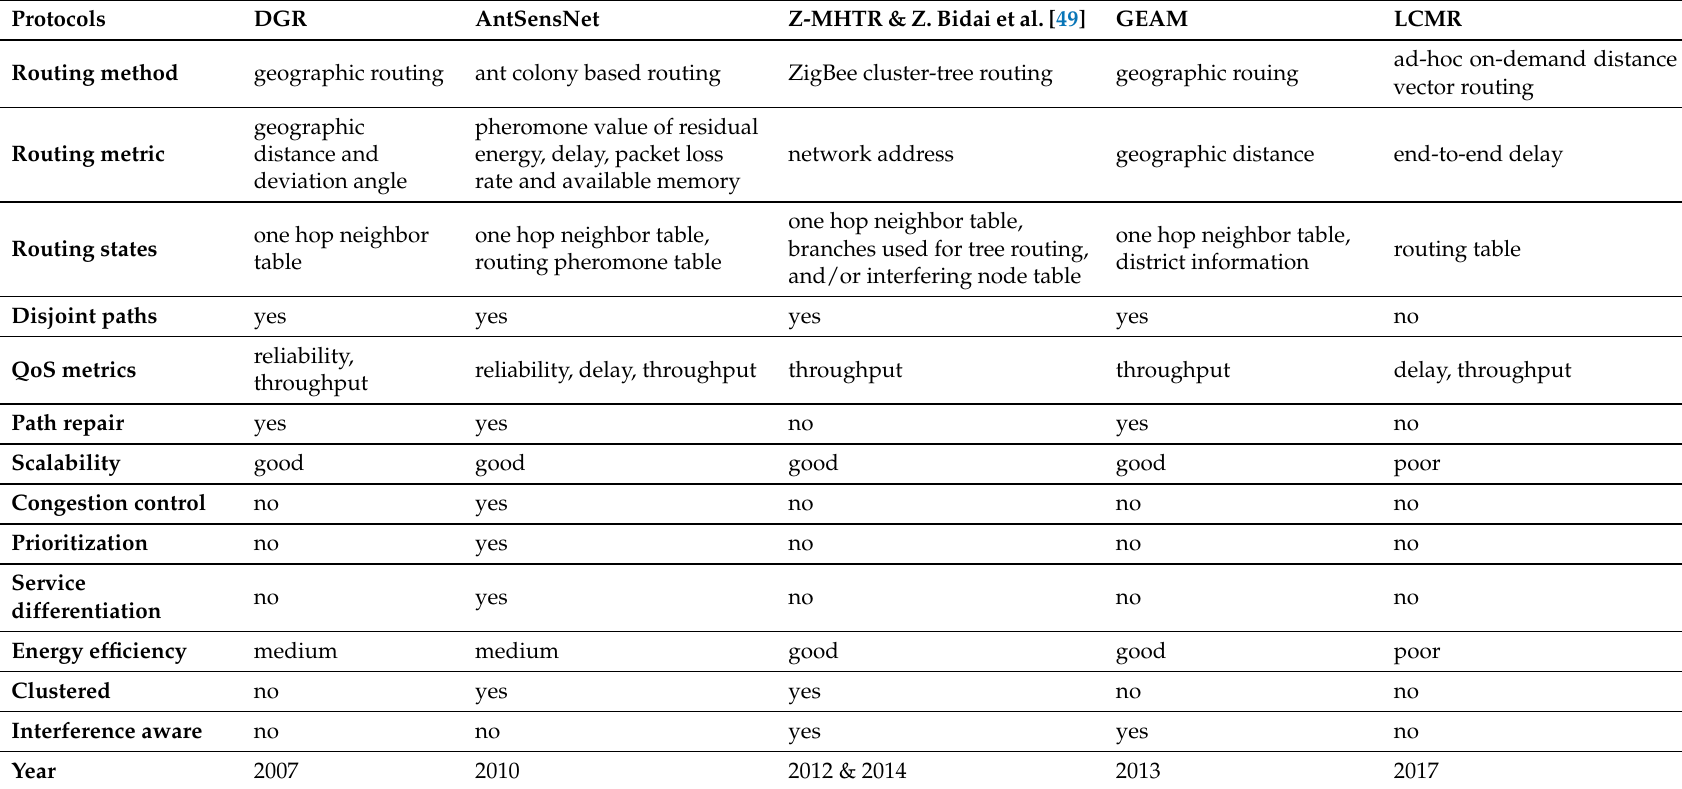
Table 3. A comparison of the surveyed multipath routing